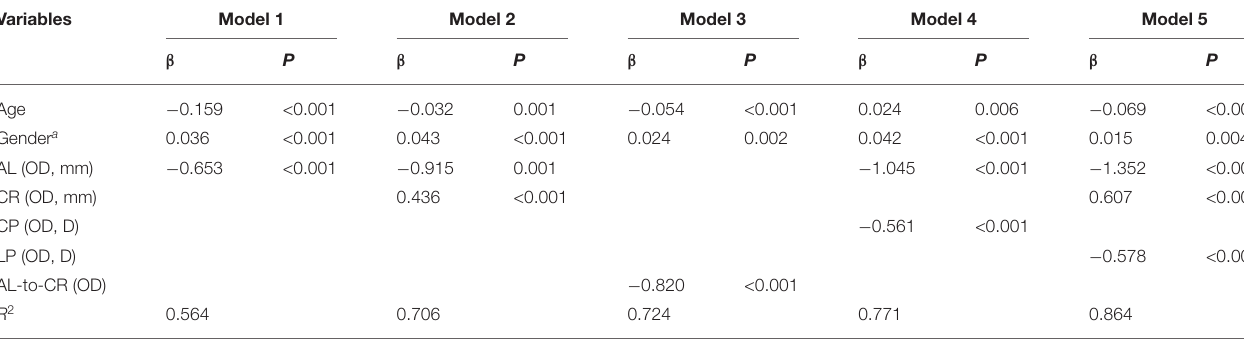
TABLE 4 | Linear regression models for SER(OD)-C with age, gender, and ocular